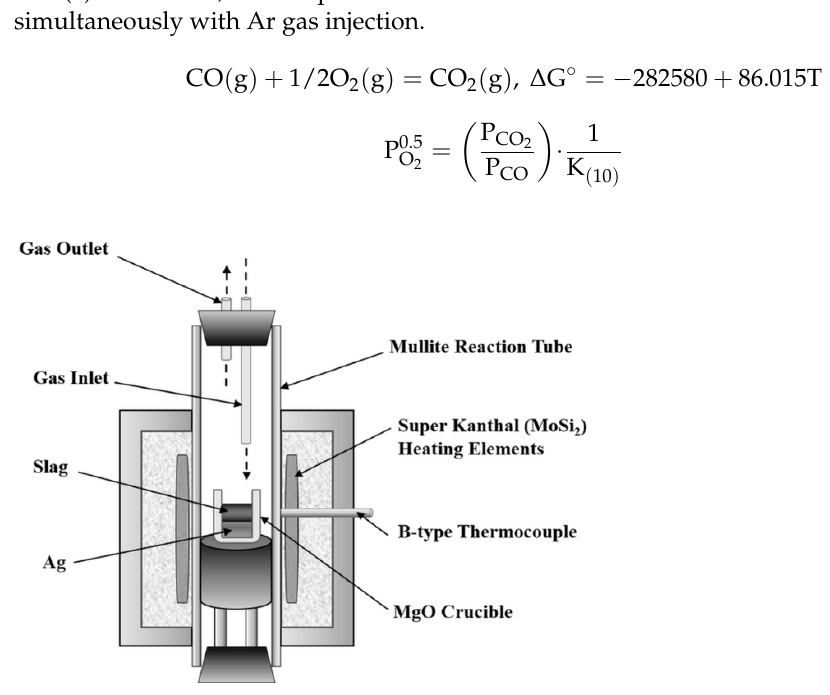
Figure 1. Experimental setup. Table 1. Initial compositions of the slag before the equilibrium experiment.